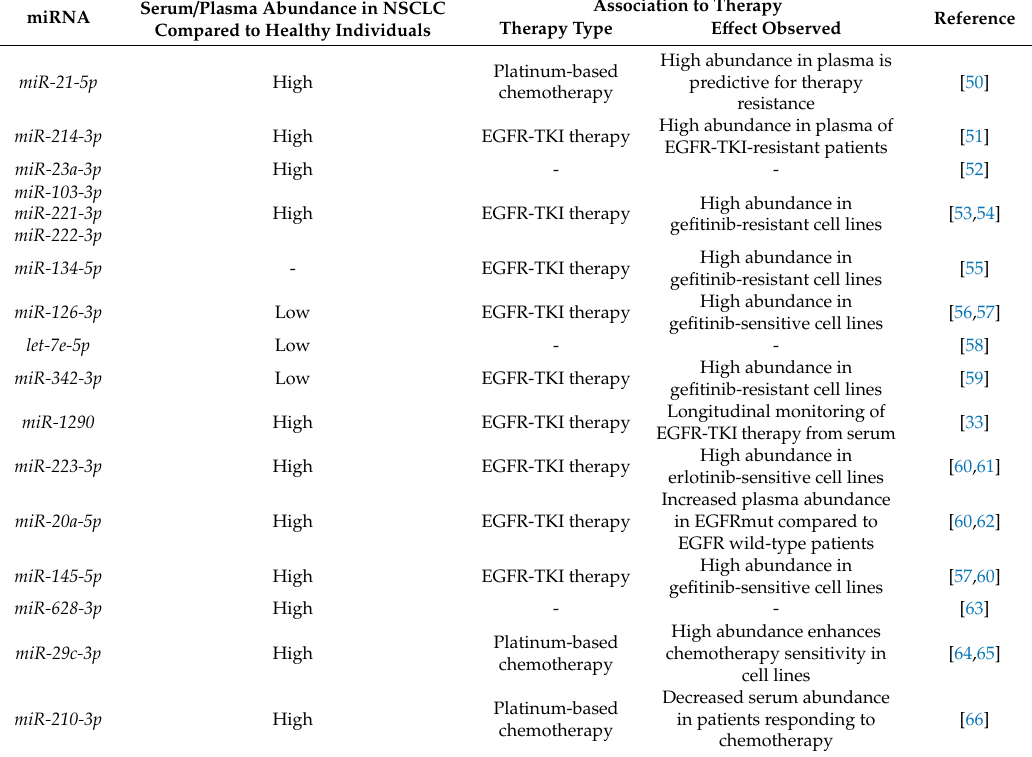
Table A1. microRNA overview and selection criteria; miRNAs were selected based on previous studies describing their (i) application for serum / plasma-based di ff erentiation of NSCLC patients from healthy individuals and (ii) association to platinum-based and EGFR -TKI therapy studied in NSCLC cell lines or serum / plasma